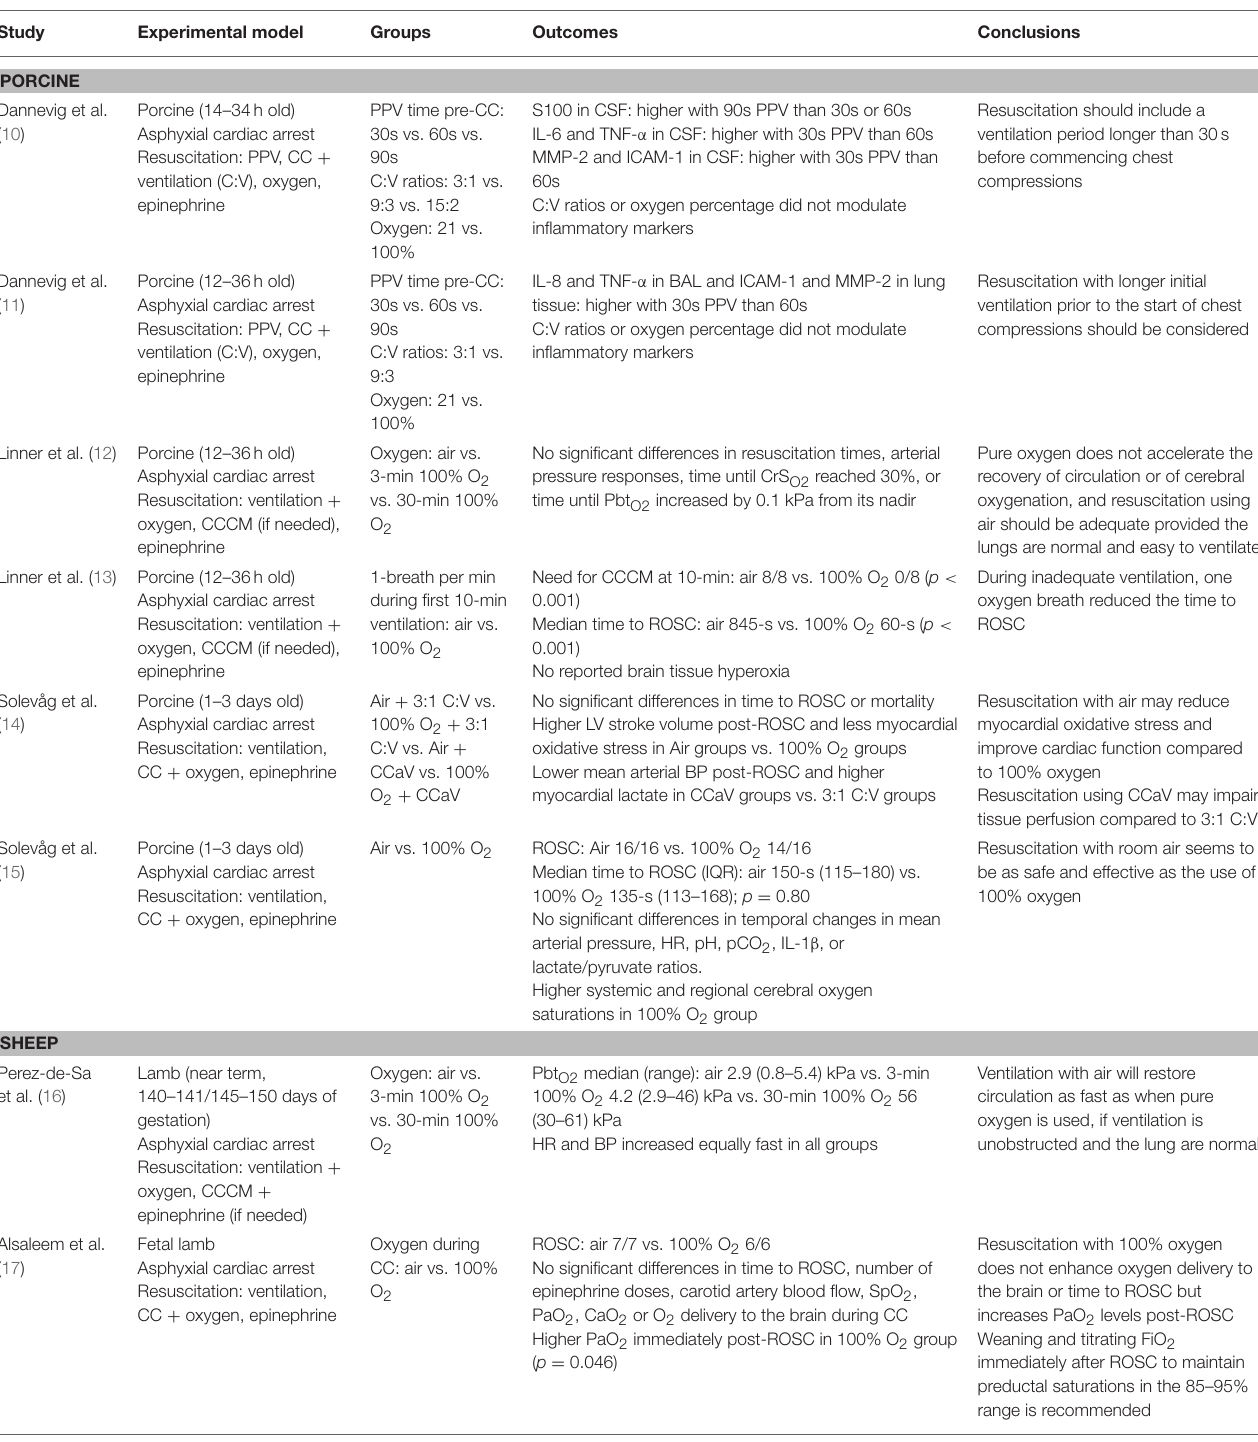
TABLE 1 | Oxygen in experimental animal models of neonatal cardiac